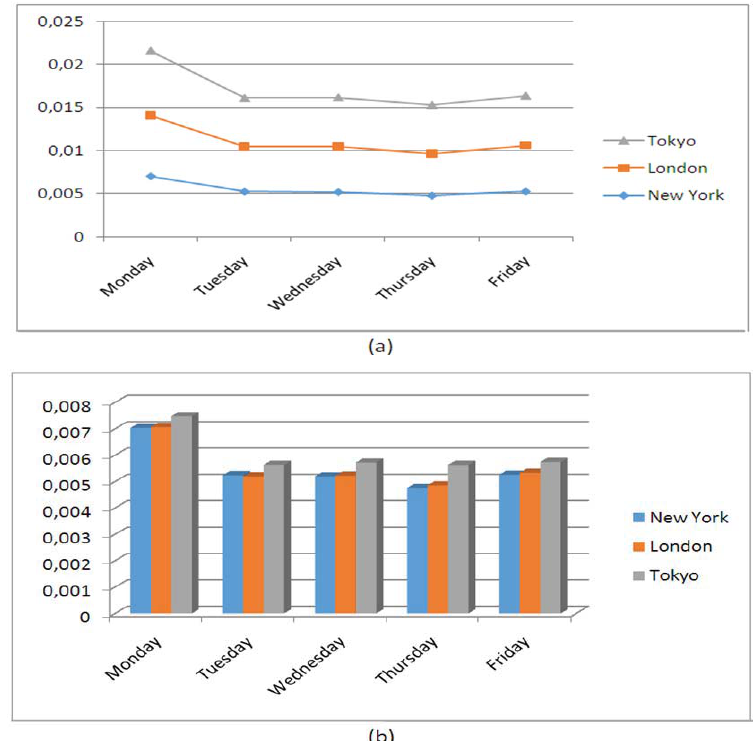
Fig. 6(a) Two-dimensional and (b) three-dimensional weekday volatility from Monday to Friday in Tokyo, London, and New